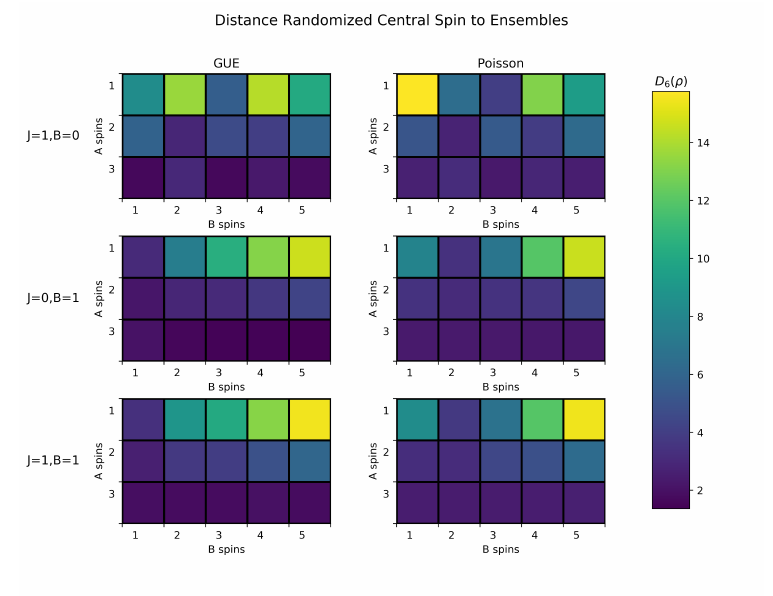
Figure 28: Left: Normalized distance of dynamics of Central Spin Model (see equation 48) to analytical GUE. Right: to analytical